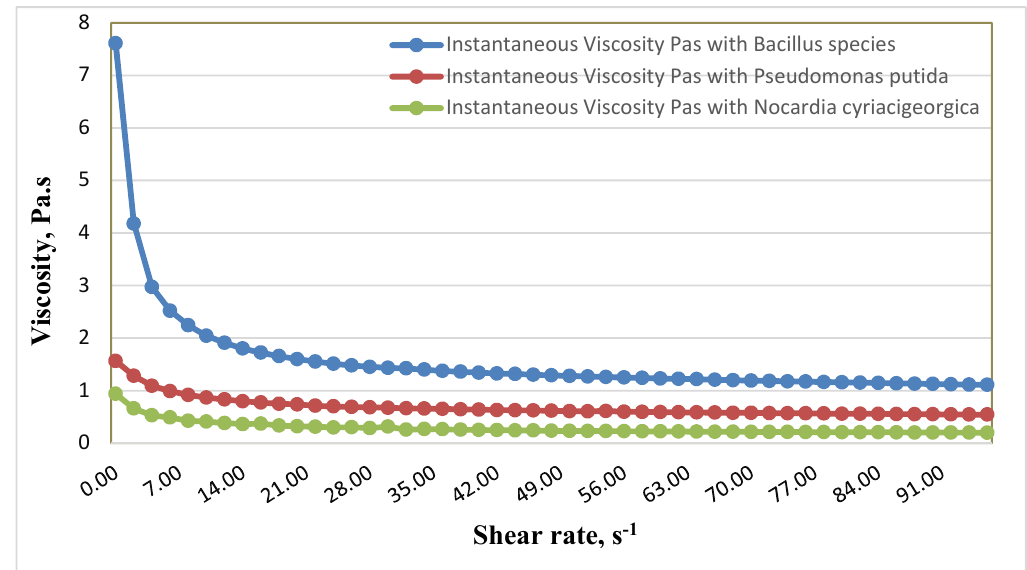
Figure 2. Reduction of viscosity of crude oil treated with Bacillus species, Pseudomonas putida, and Nocardia cyriacigeorgica at 55°C